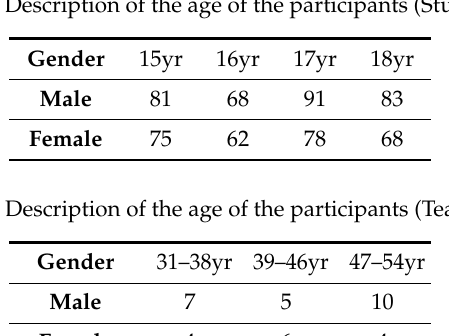
Table 1. Description of the age of the participants (Students).